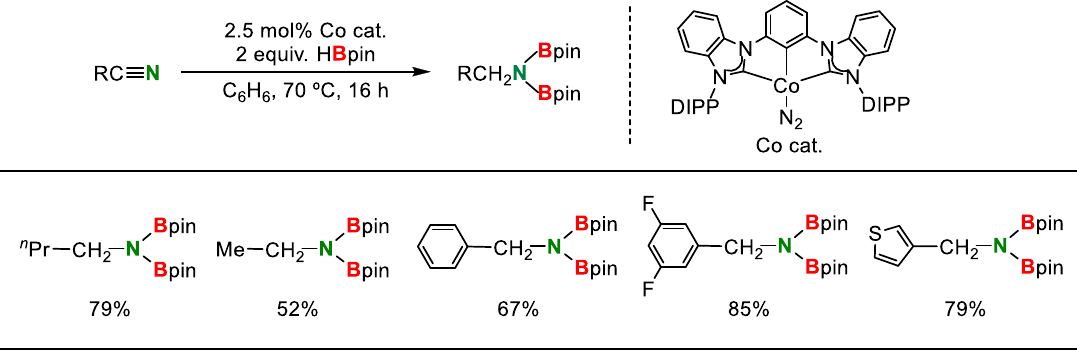
Table 8. Double hydroborylation of organonitriles in the presence of a Co complex.